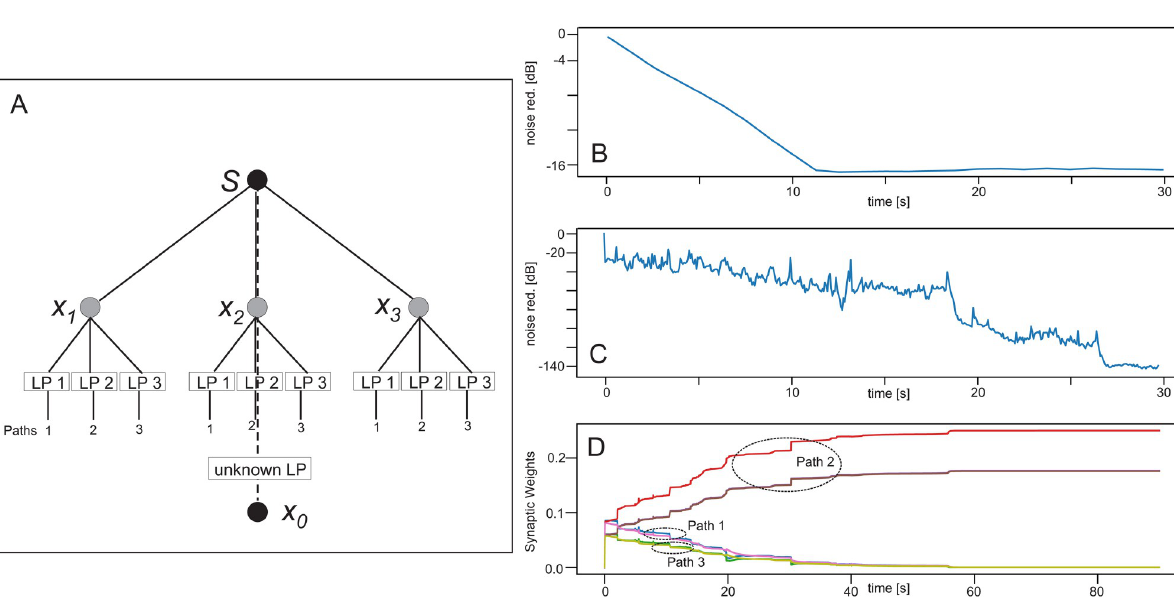
Fig 8. Noise reduction when using low-pass filtered signals. A Same geometrical configuration as in Fig 3 but now with split-up paths for the control microphones using different filters, where the cut-off for the reference microphone (so-called “unknown LP”) was 10 kHz . Learning rate: μ = 1.0 × 10 − 7 . B Noise reduction for 3 conventional control microphones without path splitting, where only one low pass has been used with cut-off of 11 kHz . Note that the here-reached level was only about 16 dB. C Noise reduction for 3 paths from the control microphones. Path 1 with cut-off of 9 kHz , path 2 with 10 kHz and path 3 with 11 kHz . D Development of the synaptic weights of all paths. Path 2 shows weight growth and, thus, has been responsible for the resulting reduction of about 140 dB see in panel